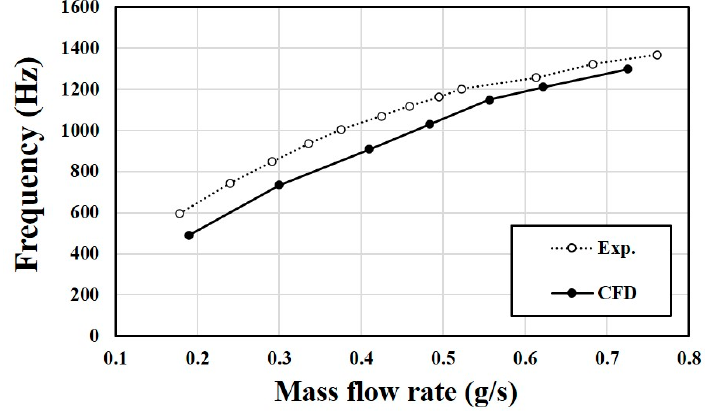
Figure 7. Validation of numerical results for frequency of fluidic oscillator using experimental data (Melton et al. [18]).